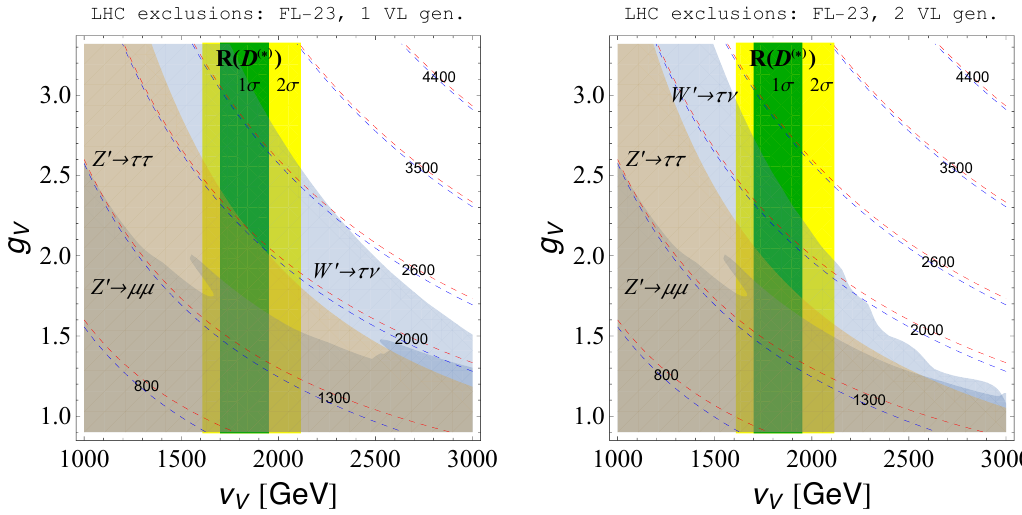
Figure 3 . The LHC exclusion limits on the Z 0 and W 0 resonances from ATLAS (cid:28) + (cid:28) (cid:0) [57], ‘ + ‘ (cid:0) [58] ( ‘ = e; (cid:22) ), and (cid:28)(cid:23) [59] searches, respectively, projected on the ( v V ; g V ) plane for the FL-23 scenario assuming the maximal fermion mixing angles s (cid:18) green (yellow) band represents 1 (cid:27) (2 (cid:27) ) range for R ( D ( (cid:3) ) ) anomaly. Dashed blue (red) isolines are the predicted masses for Z 0 ( W 0 ) gauge bosons. The plot on the left is for the minimal matter content, while the plot on the right assumes an additional family of the vector-like fermions mixing weakly with the SM fermions. Their masses are set to 0 : 8 TeV, above the limits from [61].